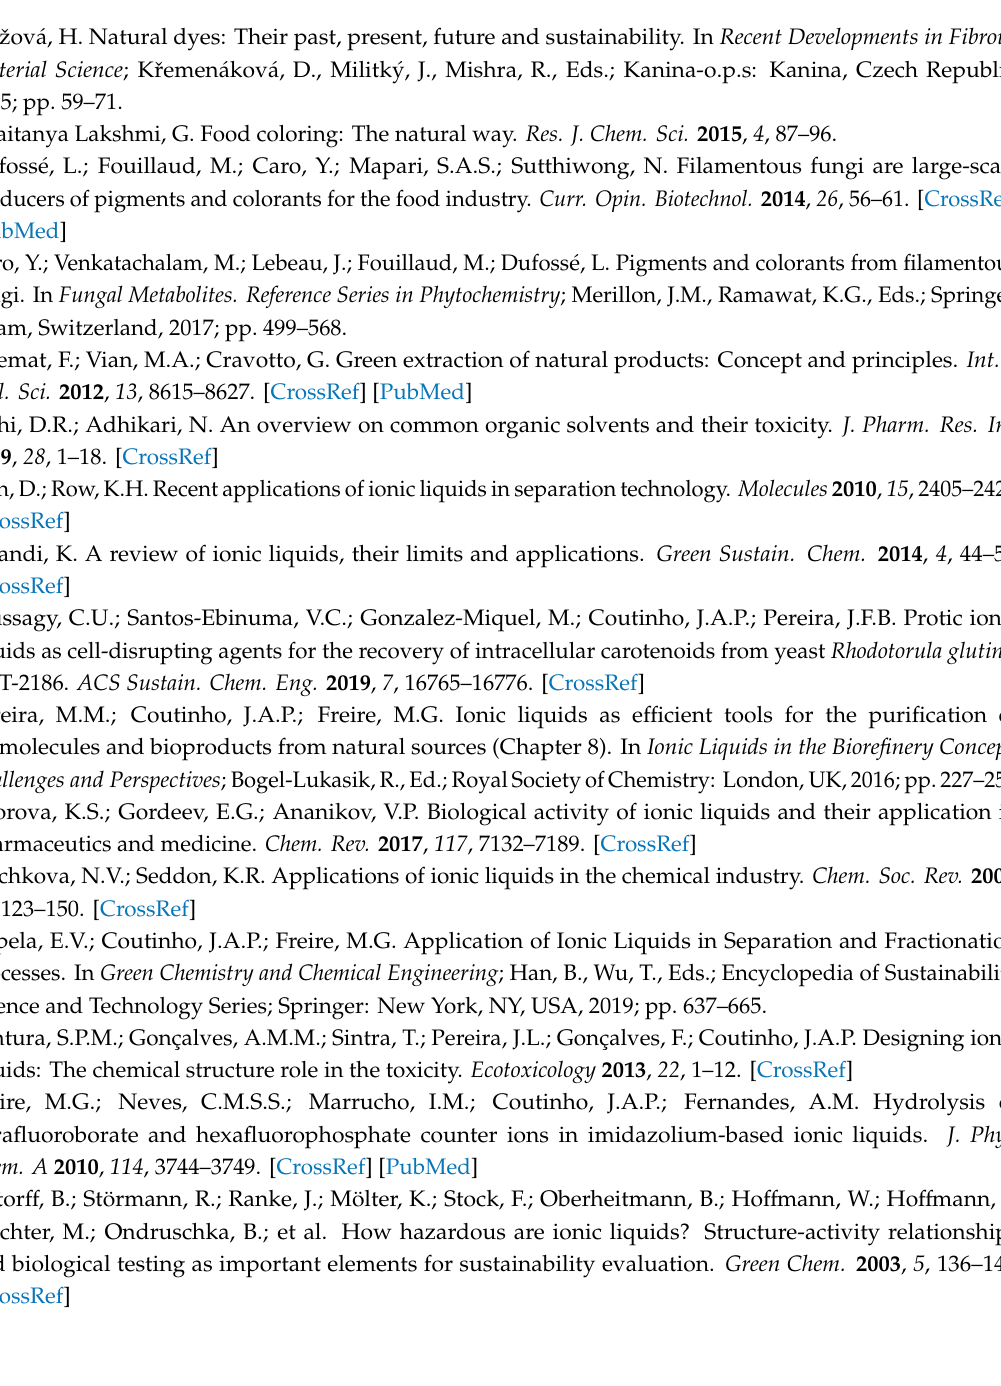
Figure S1: Visual aspect of the reverse extraction steps for each di ff erent IL-ATPS tested before (pH = 5) and after adjusting the pH (pH = 13), Figure S2: Back extraction e ffi ciency ( A ) and overall e ffi ciency ( B ) of red pigments extraction for each strain in the 4 IL-ATPS tested ( n =